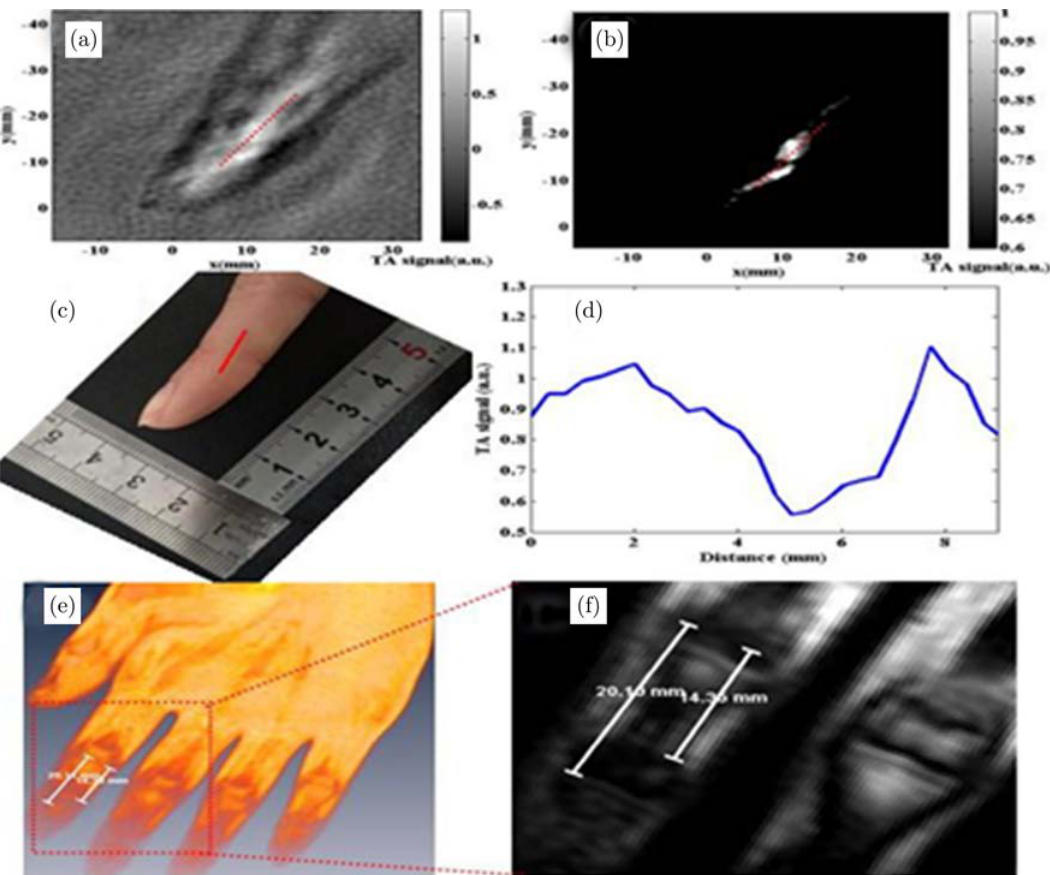
Fig. 16. (a) The TAI result of index ¯nger image of female volunteer. (b) The TAI result by setting the threshold of (a). (c) The photograph of the index ¯nger. (d) The recovered relative microwave absorption in red line. (e) The MRI results of the whole hand. (e) and (f) The TAI results corresponding to (e).